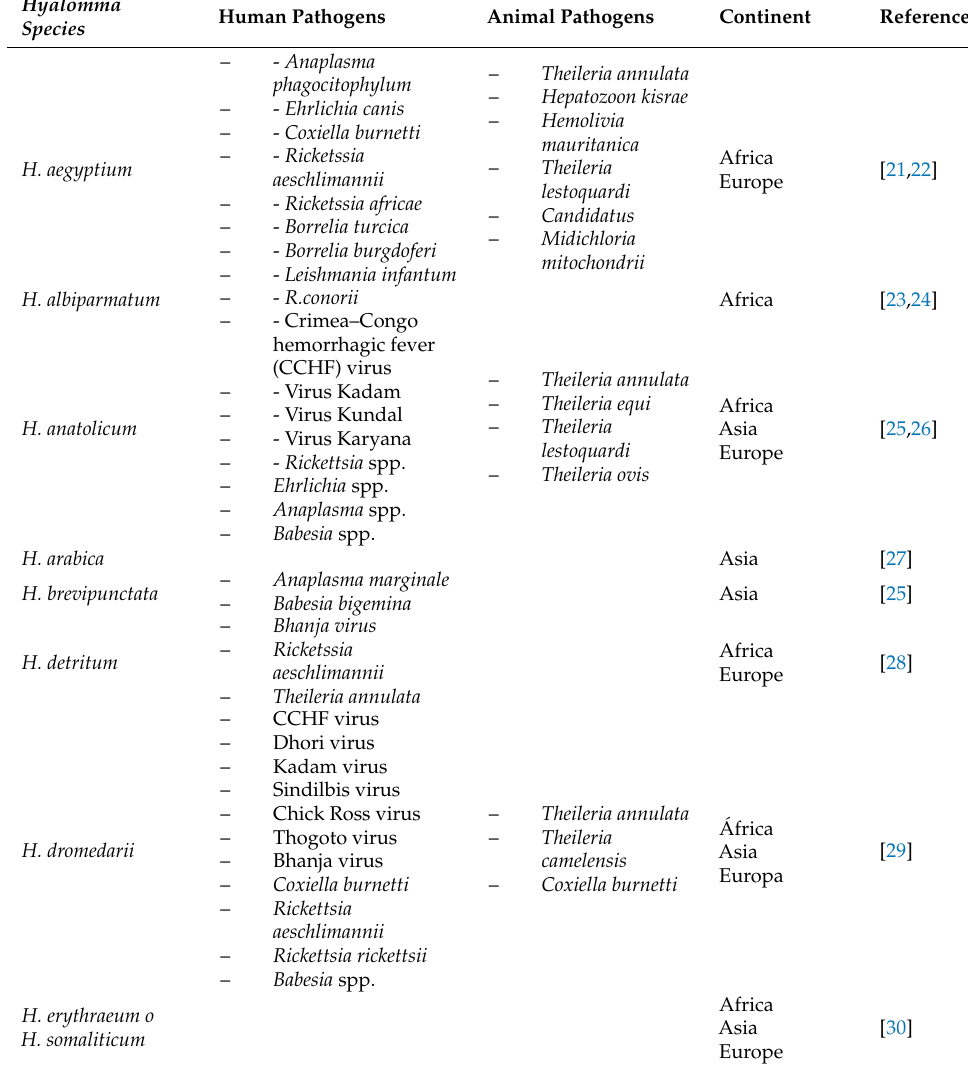
Table 1. Pathogens of human and animal importance transmitted by ticks of the Hyalomma species. Hyalomma